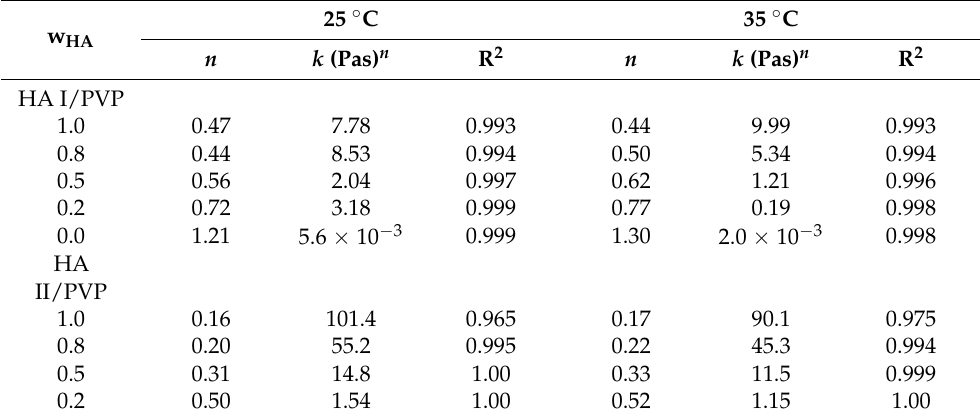
Table 1. Parameters n and k obtained by the Ostwald–de Waele equation from steady shear measure- ments. w